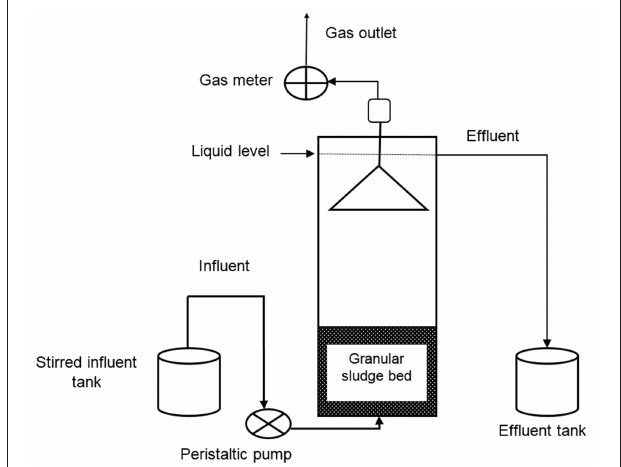
FIGURE 2 | Schematic of the UASB